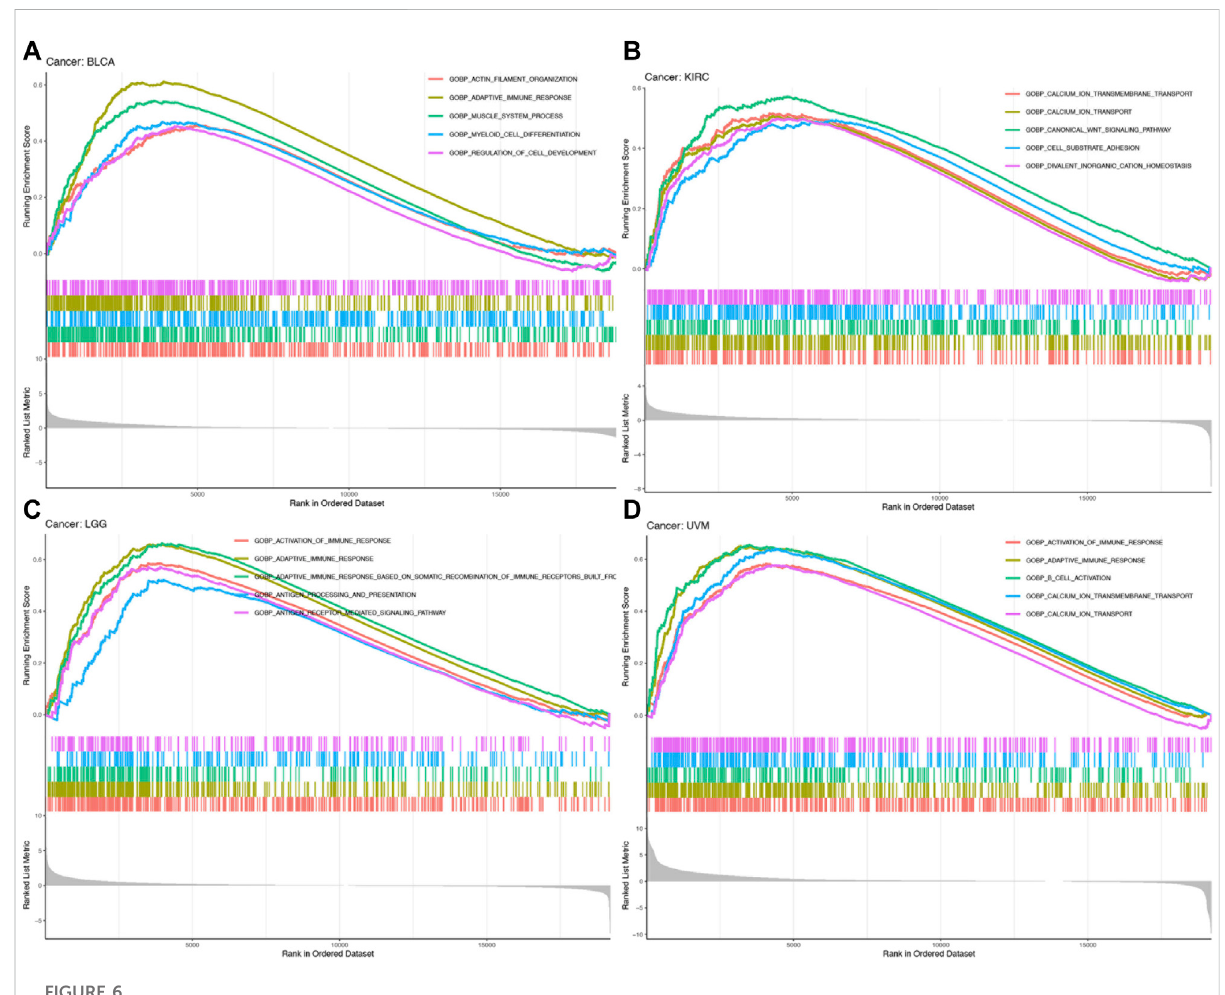
FIGURE 6 GO enrichment analysis of MRC2 in BLCA (A) , KIRC (B) , LGG (C) , and UVM (D)